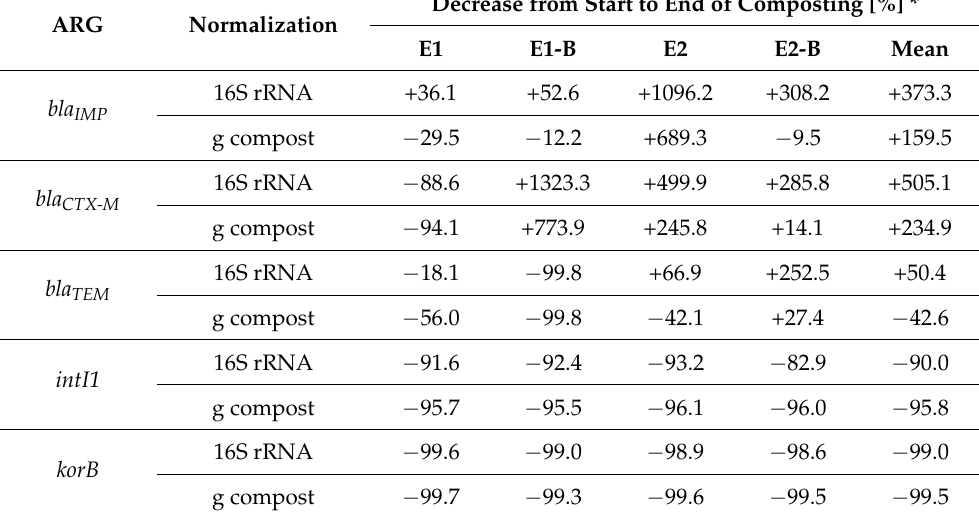
Table 2. Percentage of gene copy numbers at the end of composting, relative to the start copy numbers normalized to the 16S rRNA gene and to 1 g compost.